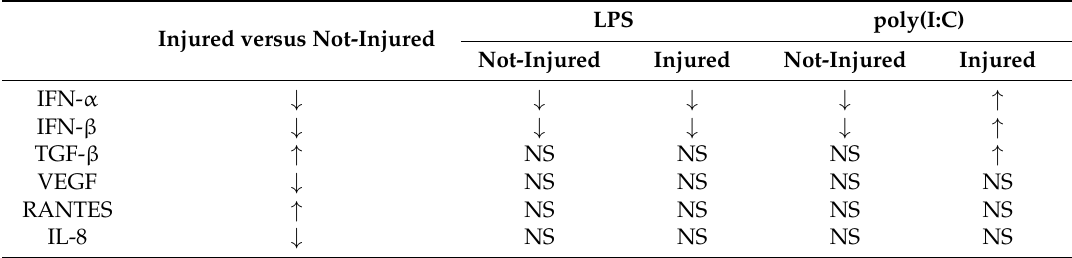
Table 2. Comparison of cytokine expression in injured and not-injured cells with and without stimulation with LPS and poly(I:C). NS, no statistically significant difference.